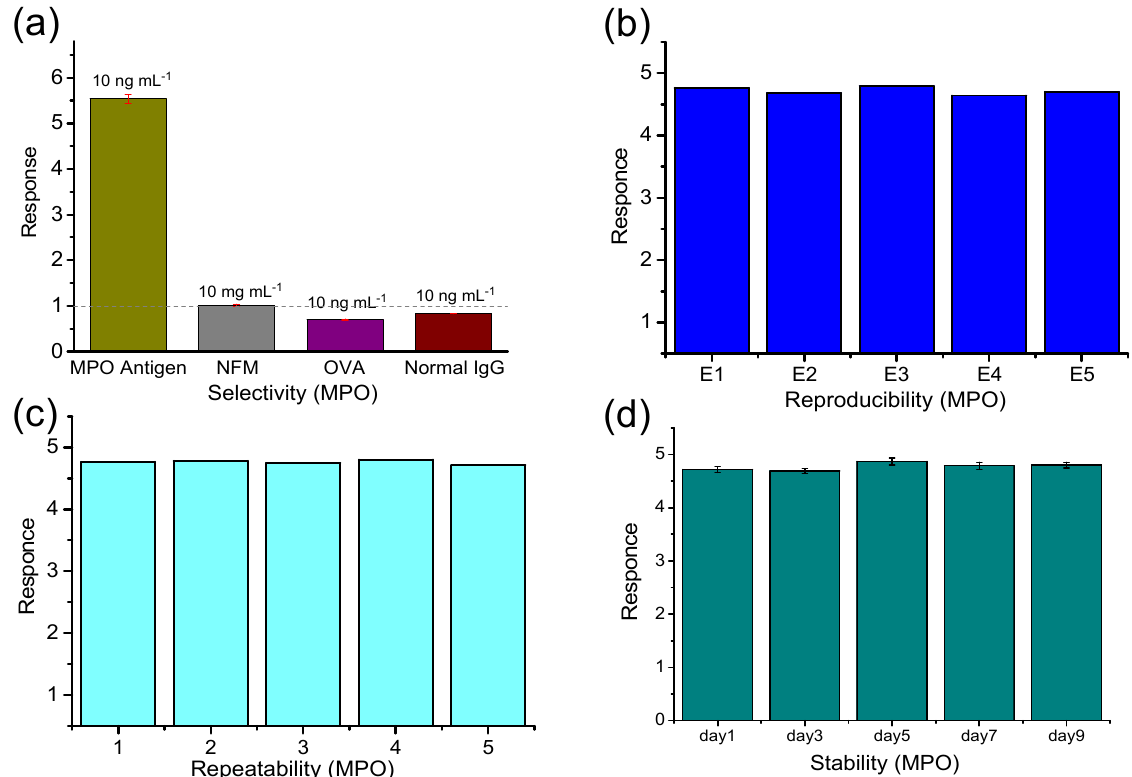
Figure 6. Sensing characteristics: ( a ) Selectivity; ( b ) Reproducibility (single measurement results of five electrodes: E1–E5); ( c ) Repeatability (repeat the measurement five times on one electrode) and ( d ) Stability.